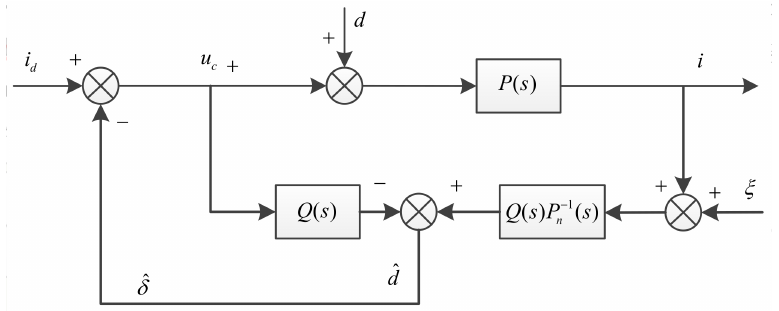
Figure 5. Disturbance observer after structural